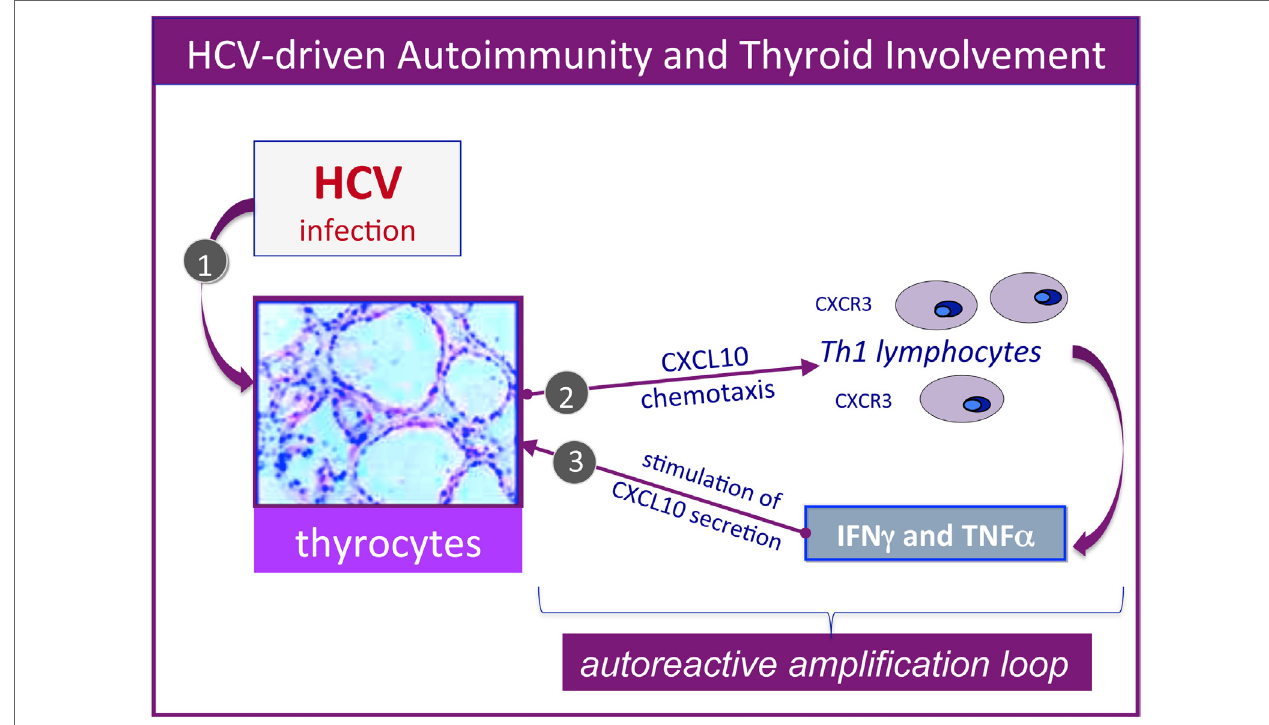
FigURe 2 | Hepatitis C virus (HCV)-driven autoimmunity and thyroid involvement. Autoimmune thyroid involvement can be observed in a significant proportion of chronically HCV-infected patients; the possible etiopathogenetic mechanisms are schematically described in the figure. In genetically predisposed subjects, HCV thyroid infection (1) may lead to the upregulation of CXCL10 gene expression and secretion in thyrocytes (2); this chemokine may promote the recruitment of Th1 lymphocytes, which secrete interferon- γ (IFN γ ) and tumor necrosis factor- α (TNF α ). These cytokines may in turn induce CXCL10 secretion by thyrocytes (3), thus perpetuating the immune-mediated pathogenetic cascade. The consequence may be the appearance of thyroid disorders; a comparable pathogenetic mechanism may be hypothesized for HCV-driven diabetes type